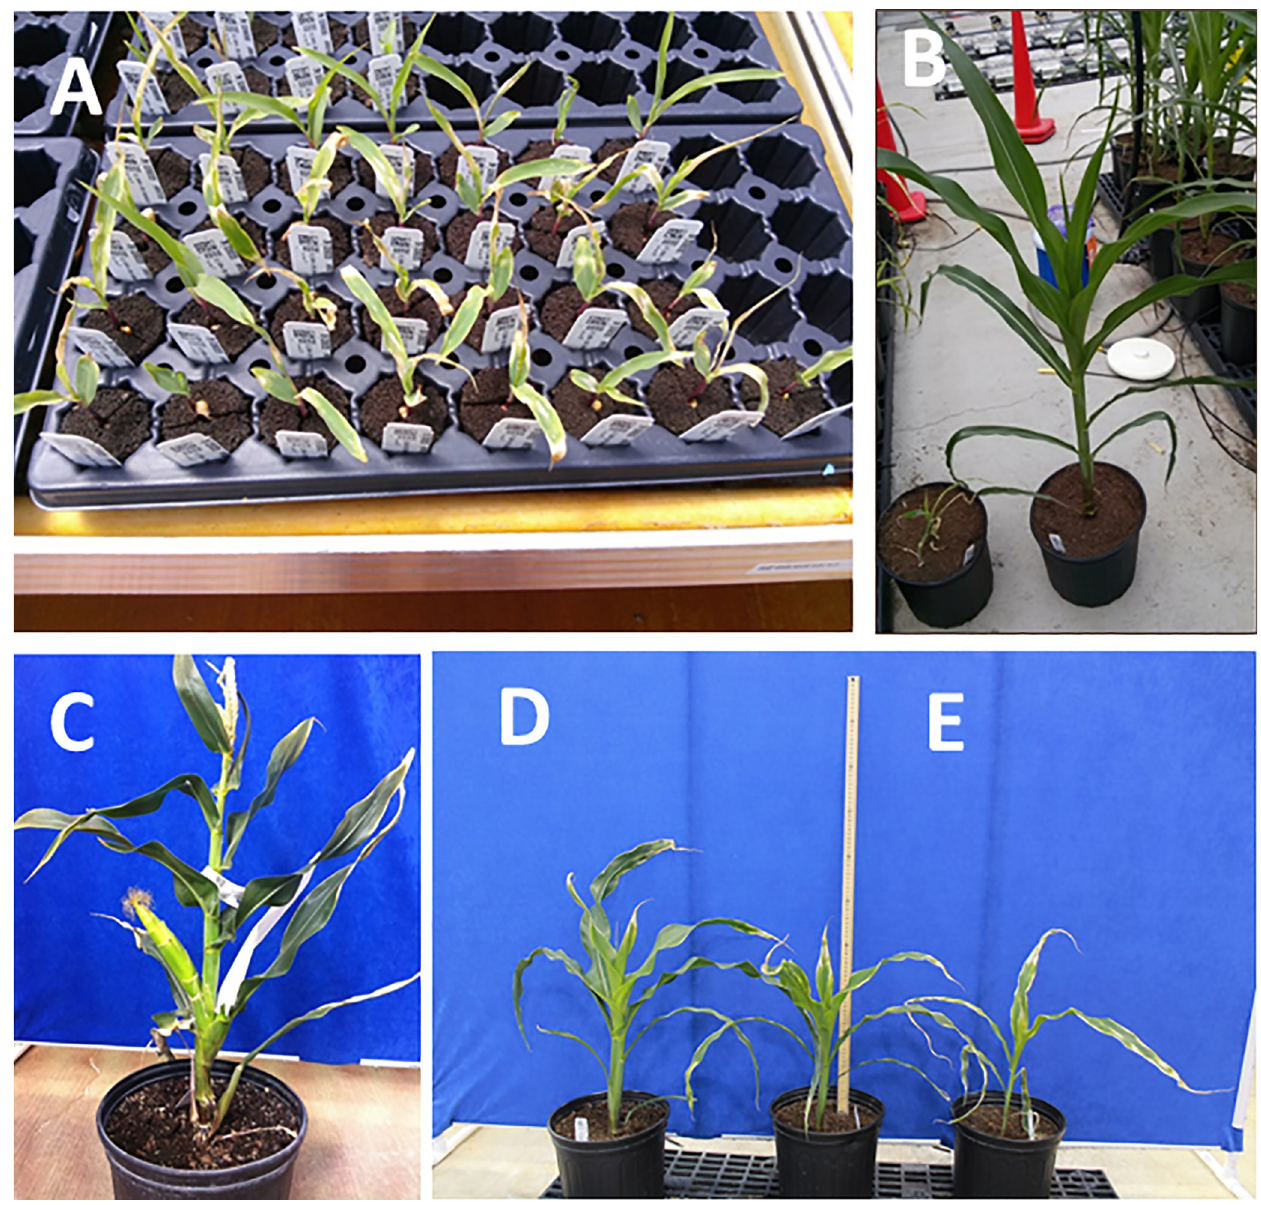
Fig 7. Growth deformities upon perturbation of GABA shunt pathway. A : SSADH 10-day-old seedlings; B : 30-day-old, SSADH on the left, wild-type on the right; C : 60-day-old SSADH plant; D : Wild-type plant on the left, two SCoAL plants on the right.